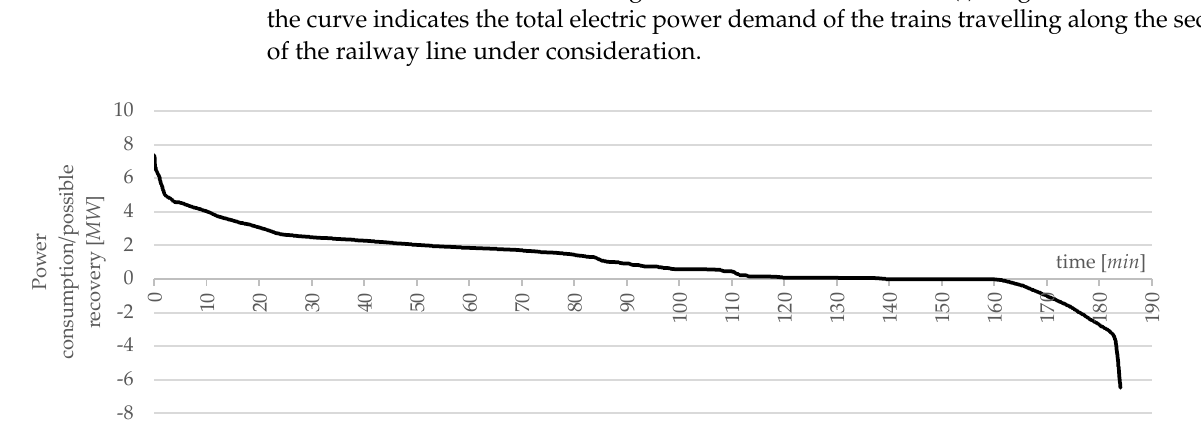
Figure 5. Power consumption/possible recovery in the variant before reconfiguration. The basic data characterising this option are summarised in Table 4